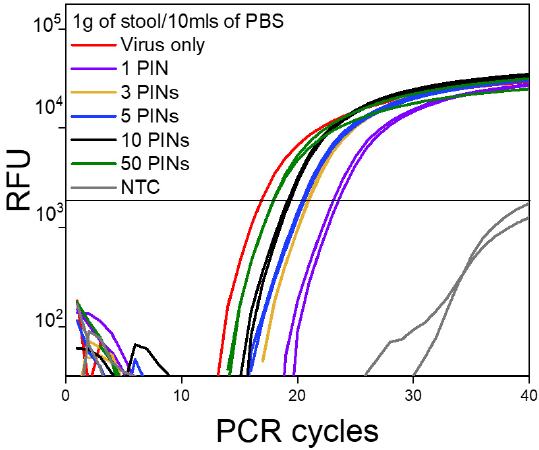
Figure 4. The log amplification curve for 1 g/10 mL of stool samples against the number of PIN particles used ( n = 15).